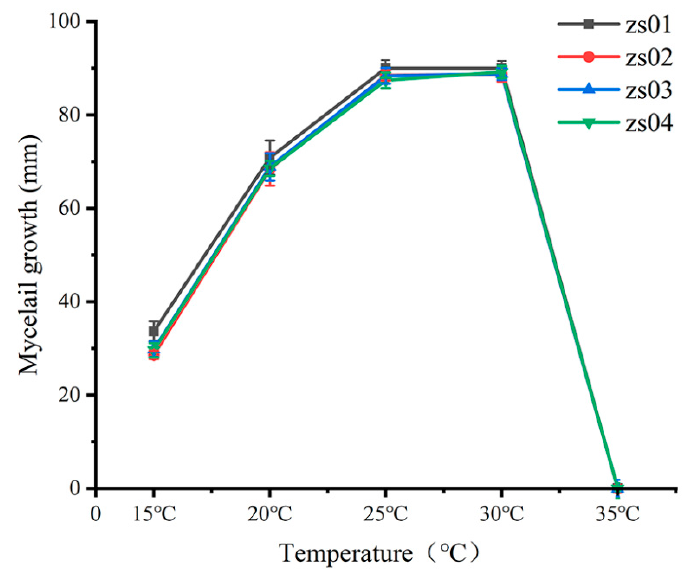
Figure 5. Effect of temperature on colony diameter growth of isolates ZS01–04 after 3 days of culture on V8-agar media.